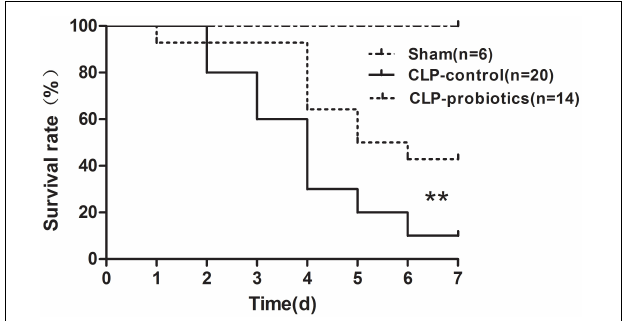
FIGURE 1 | Survival of septic C57BL/6J mice with or without LCBE treatment. Seven-week-old C57BL/6J mice pretreated with LCBE ( n = 14) or normal saline ( n = 26) for 1 week. All of C57BL/6J mice treated with LCBE and 20 of C57BL/6J mice treated with normal saline were subjected to CLP surgery, while the rest six of C57BL/6J mice treated with normal saline were carried out a sham laparotomy. After surgery, all mice were monitored for 7 days and survival of groups were compared. ∗∗ P < 0.01 (CLP-probiotic vs.